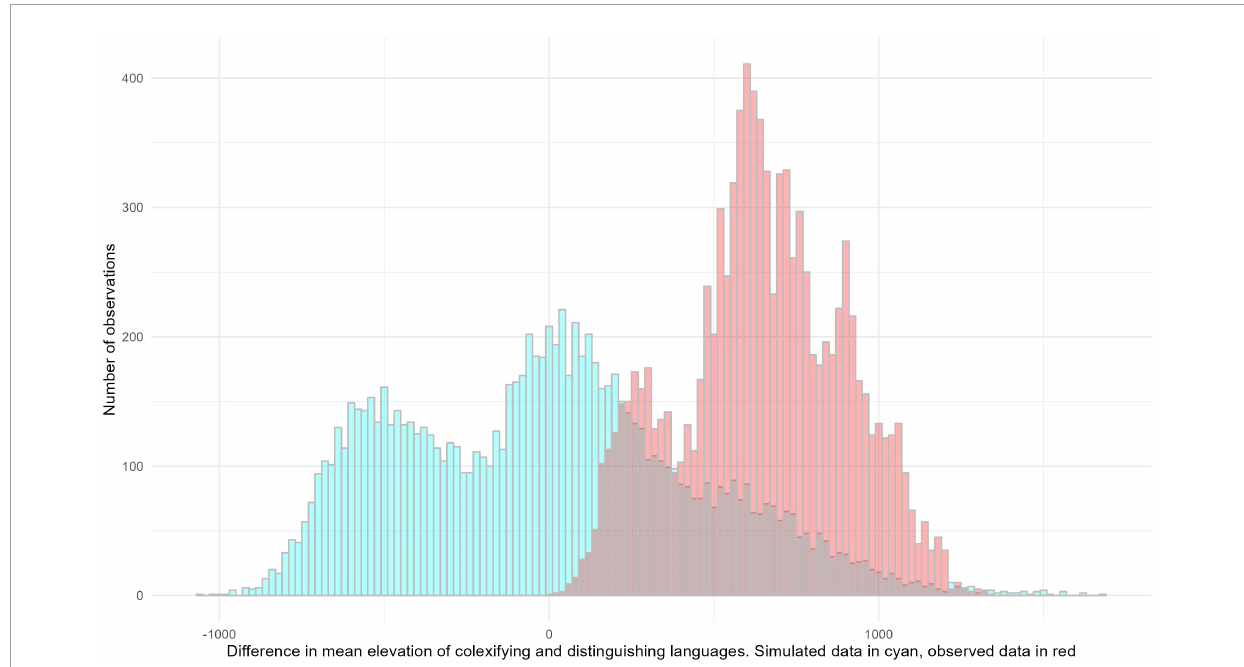
FIGURE3 Distribution of the difference between observed elevation means for colexifying and distinguishing languages in 10,000 samples drawn from the full Andean dataset and corresponding simulated means after randomization.